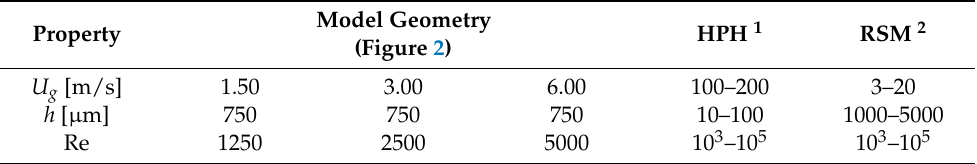
Table 1. Flow settings in the model device compared to industrial high-pressure homogenizers (HPHs) and rotor-stator mixers